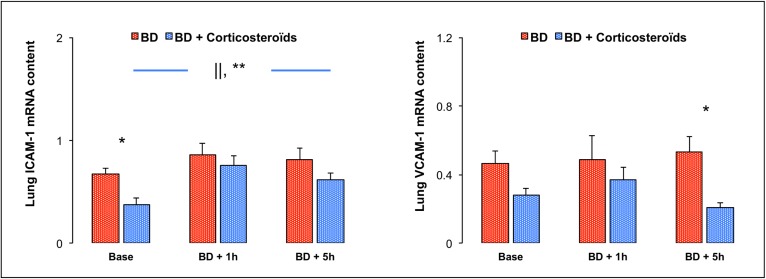
Relative lung mRNA expression of intercellular adhesion molecule (ICAM) and vascular cell adhesion molecule (VCAM)-1 at baseline, one (BD + 1 hour) and five (BD + 5 hours) hours after Cushing reflex in the placebo-pretreated brain death (BD group; n = 11; red bars) and in the methylprednisolone-pretreated brain death (BD + Corticosteroids group; n = 8; blue bars) groups. Values are expressed as mean ± SEM. * p<0.05 BD versus BD + Corticosteroids; || p<0.05 Base versus BD + 1 hour, ** p<0.05 Base versus BD + 5 hours in the BD + Corticosteroids group.